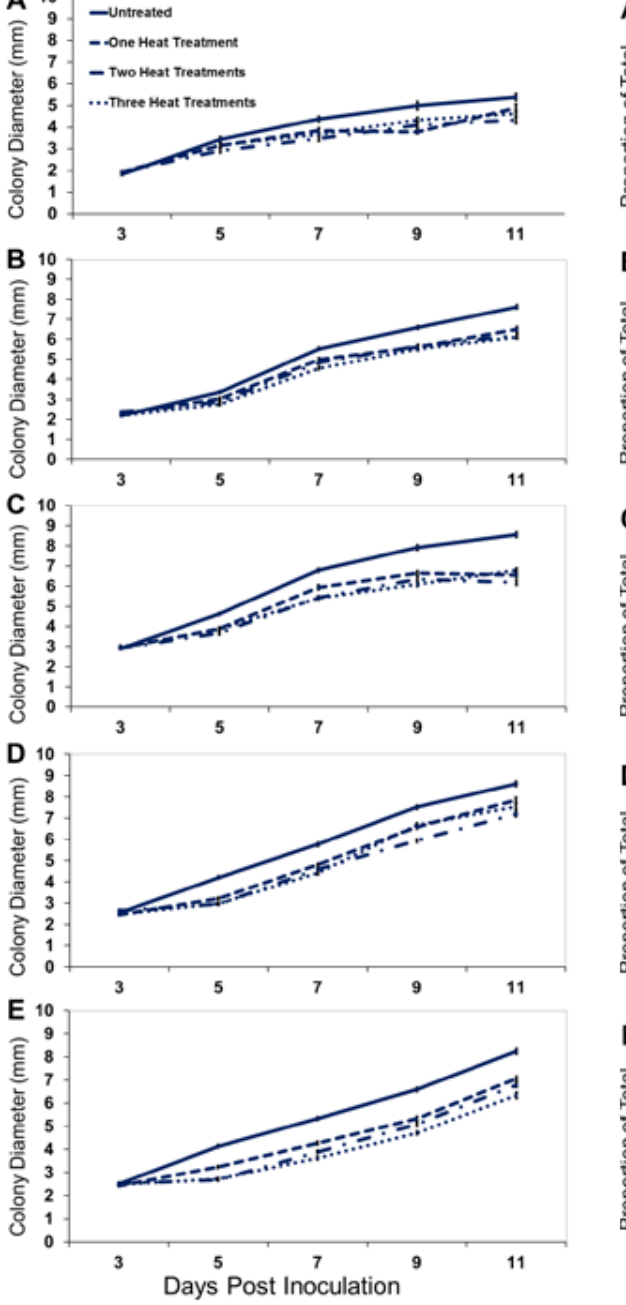
Figure 2. Erysiphe necator latent periods (d) for different temperature and heat exposure groups at A) 31°C, B) 33°C, C) 35°C, D) 37°C, and E) 39°C.